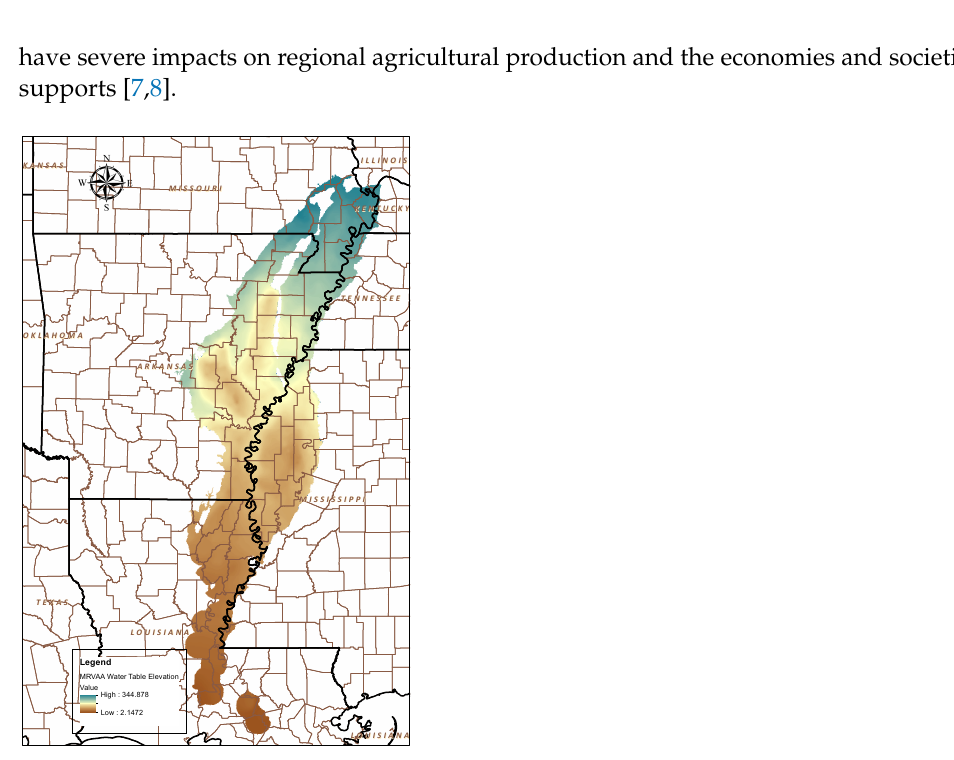
Figure 1. Potentiometric map of the Mississippi River Valley Alluvial Aquifer based on U.S. Geologi- cal Survey data from